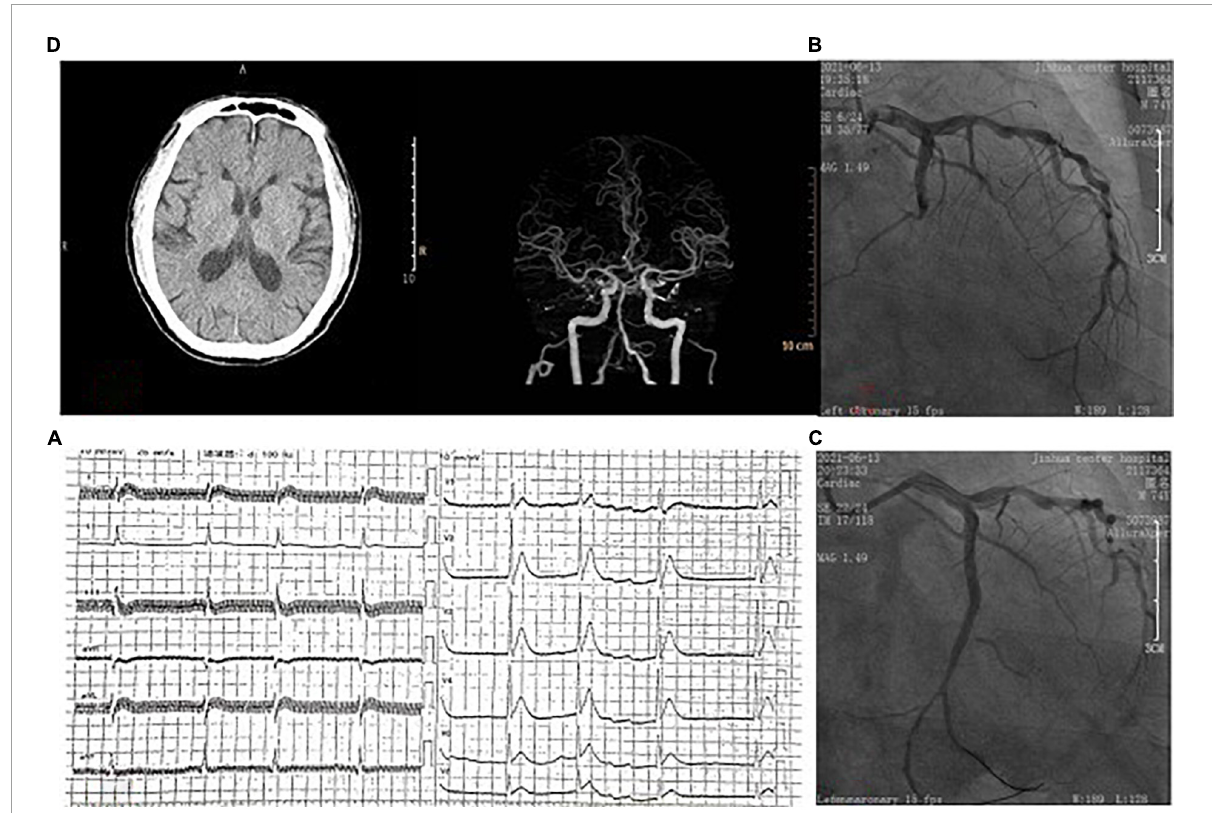
FIGURE1 (A) On admission, ECG showed atrial fibrillation and ST-segment elevation in the anterior wall leads. (B) Coronary angiography showed occlusion of the left circumflex artery. (C) Blood flow was restored after coronary stent implantation. (D) Brain computed tomography showed no hemorrhage before intravenous thrombolytic